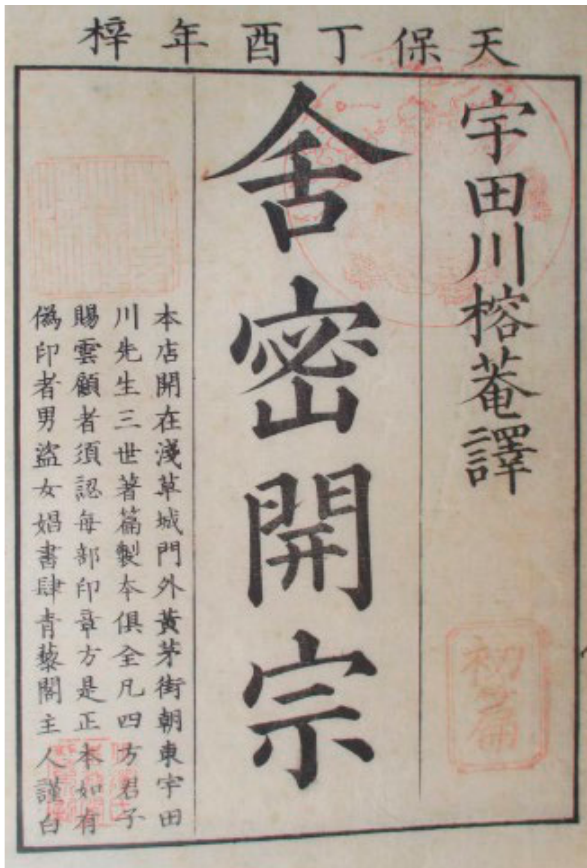
Figure 3. Seimi Kaiso first page of the first book. Photo: Y.